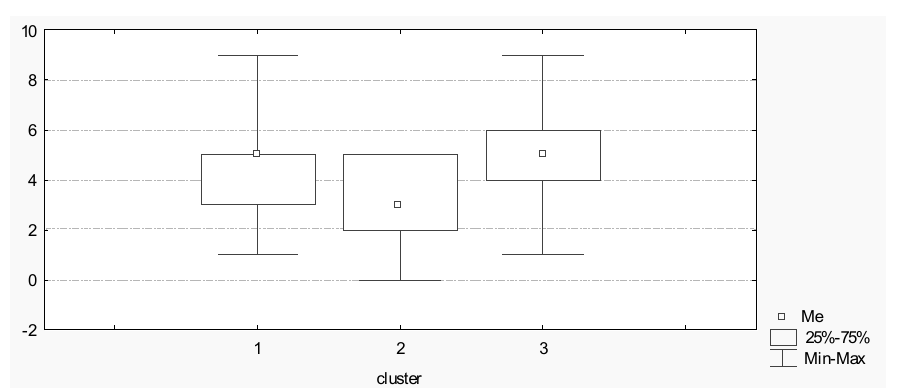
Fig. 3. The distribution of the answers of the students of three clusters to the question “Do the condi- tions created by the state facilitate the achievement of your objectives?” Source: Authors`